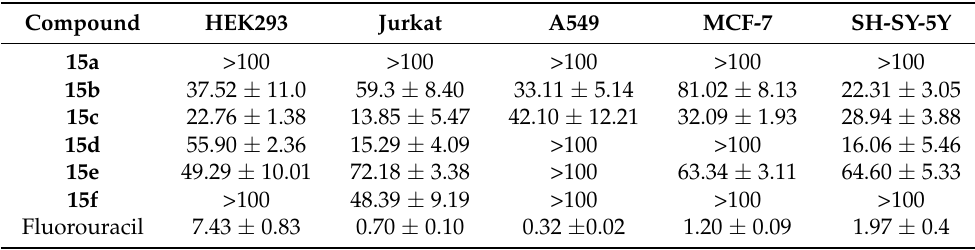
Table 5. In vitro growth inhibitory effects, IC 50 ( µ M), of compounds 10a – 10f and fluorouracil in